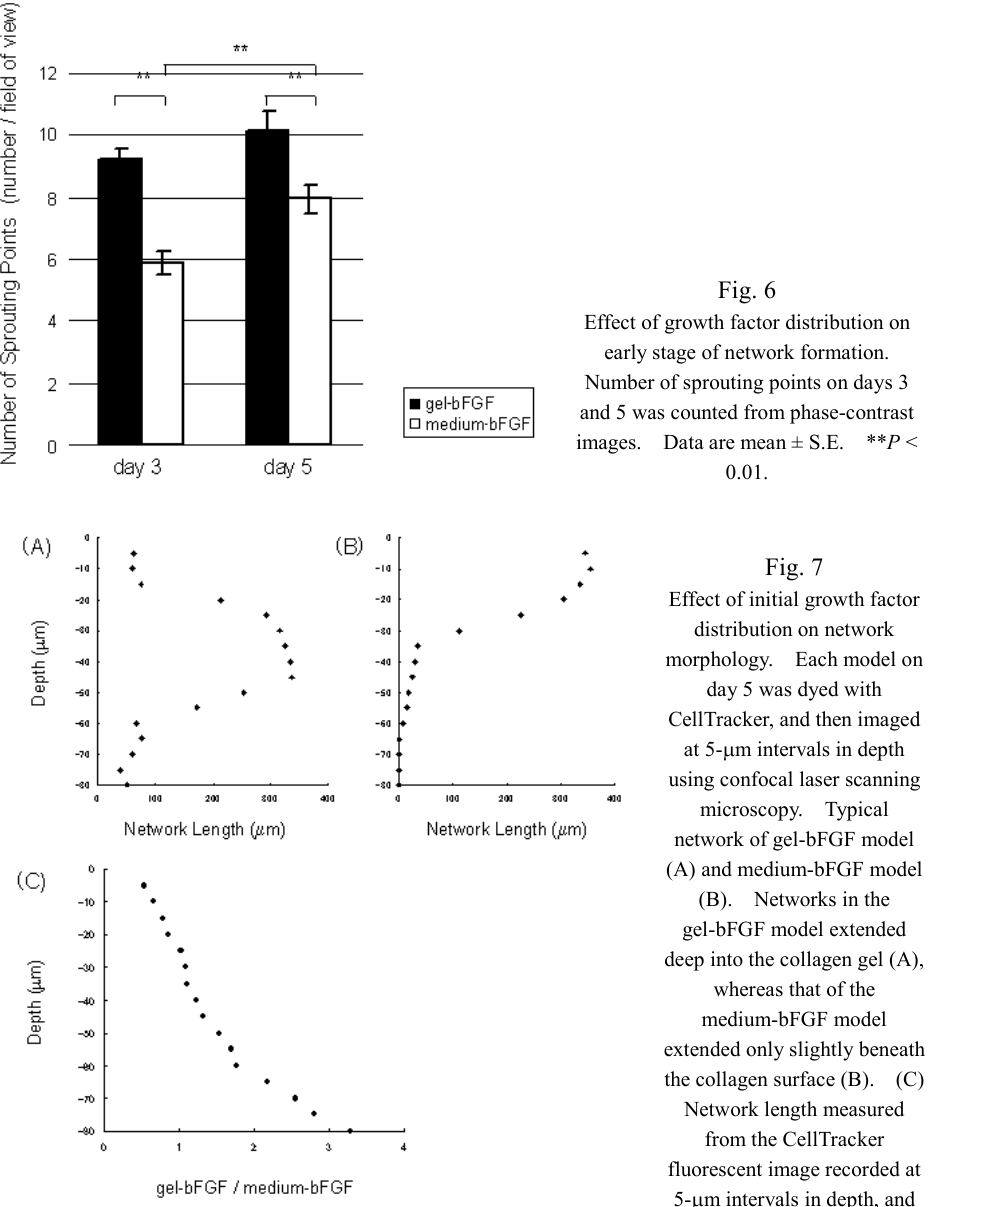
calculated ratio of average network length in the gel-bFGF model to that in the medium-bFGF model. Networks in the gel-bFGF model tended to extend deeper, whereas those in the medium-bFGF model tended to extend only to a shallow position. Data are mean